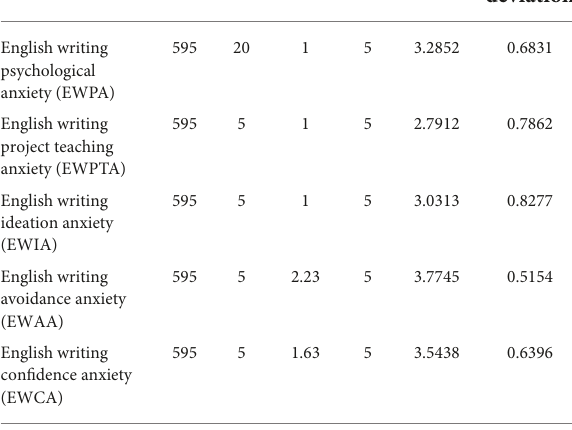
TABLE 2 Results of descriptive analysis of English writing psychological anxiety. N